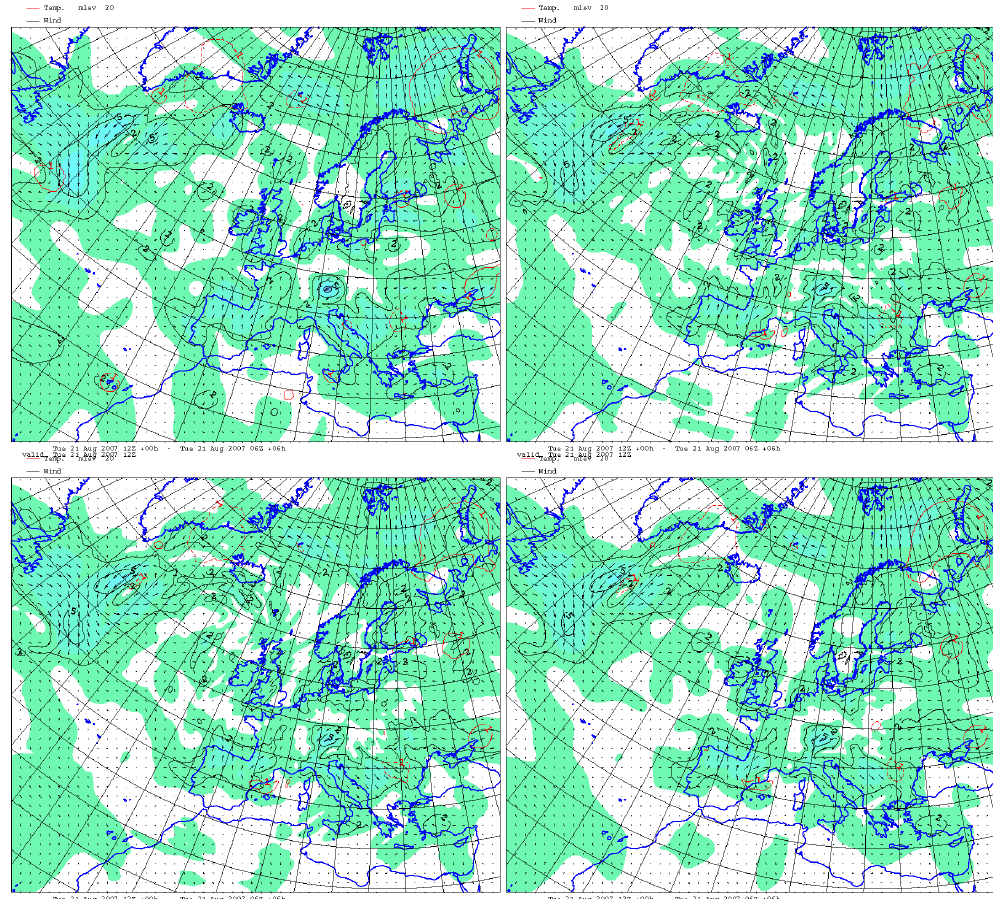
Fig. 6. Example of assimilation increments for wind speed at model level 10 (black lines and colour-shading) and temperature at model level 20 (red lines) on 21 August 2007 12:00UTC. 3D-Var (upper left panel); hybrid with different horizontal spectral densities for the ensemble weights: same spectral densities as for assimilation of un-balanced surface pressure in 3D-Var (upper right panel), spectral density corresponding to a power law correlation with 500km length scale (lower left panel) and spectral density corresponding to a windowed power law correlation with a 200km length scale (lower right panel). All experiment are based on a 50% contribution from the climatological component and a 50% contribution from the ensemble component to the background error covariance. Isoline spacing 2.5ms − 1 and 1K. Different shades of green indicate the intervals between 1, 3, 6, 8 and 10ms − 1